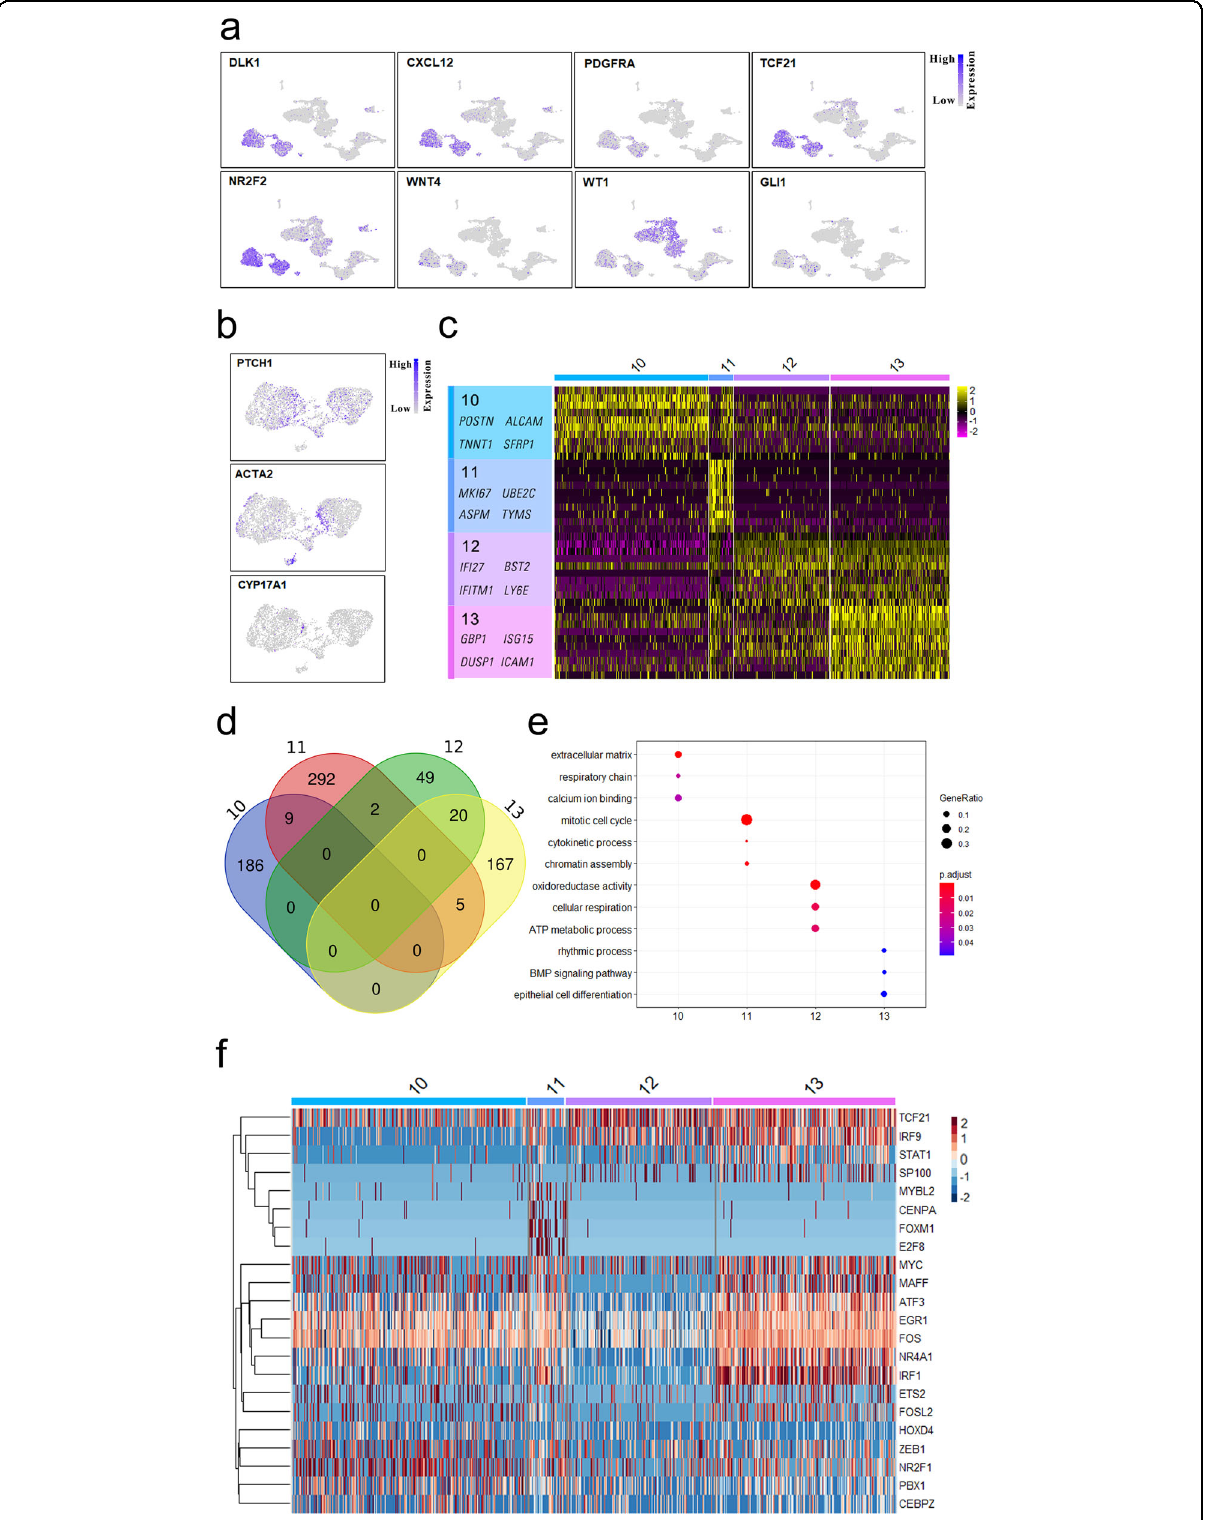
Fig. 6 Dynamic changes of transcriptome in theca cells. a UMAP cluster map showing expression of selected known marker genes for Leydig cells. b The expression patterns of theca cell-associated marker genes. c Heatmap showing representative differentially expressed genes across theca cell populations. d Venn diagram shows overlapping of differentially expressed genes among theca cell populations. e Top GO terms within the differentially expressed genes unique to the theca cells. f Hierarchical clustering of the critical transcription factors among theca cell